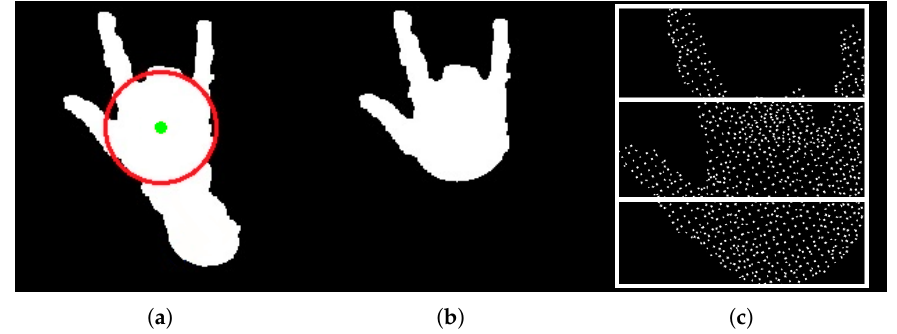
Figure 3. ( a ) Binary image of an arm with the circle C fitted in the palm region and circle center C c marked as a green dot; ( b ) binary image of a hand after rejecting the wrist region; ( c ) point cloud of a hand and its bounding box divided into three horizontal cells (projection on the x , y